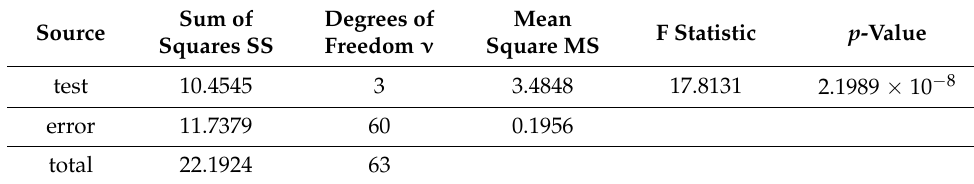
Table 4. Total SSQ score ANOVA summary.